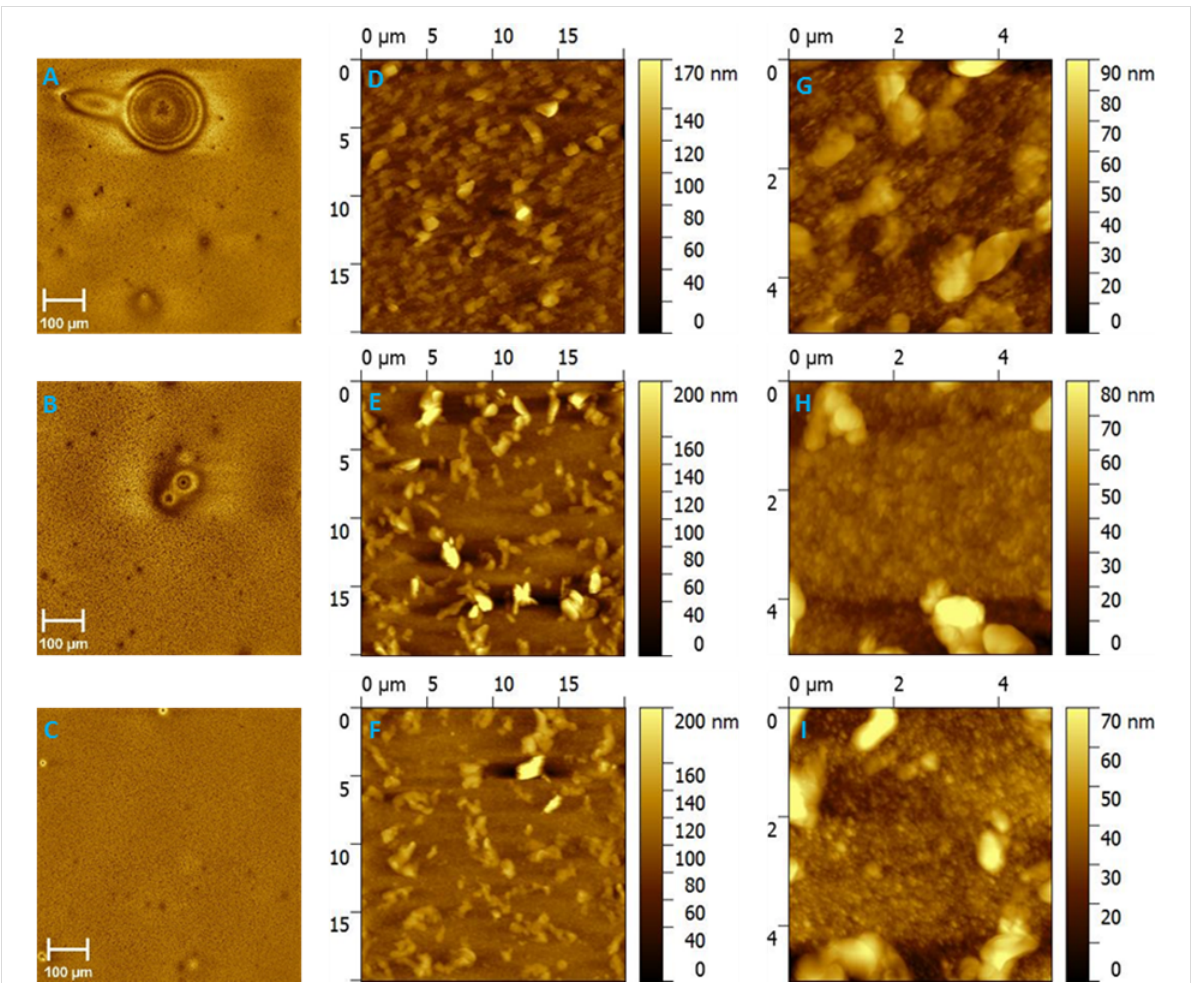
Figure 4: Optical microscopy (A–C), scale bar 100 µm, AFM images with scale bar 20 × 20 µm (D–F) and 5 × 5 µm (G–I) of P3HT:ICxA NPs with dilu- tion factors 1.6 × 10 4 (A,D,G), 9.8 × 10 6 (B,E,H) and 6.1 × 10 9 (C,F,I) for crossflow ultrafiltration.